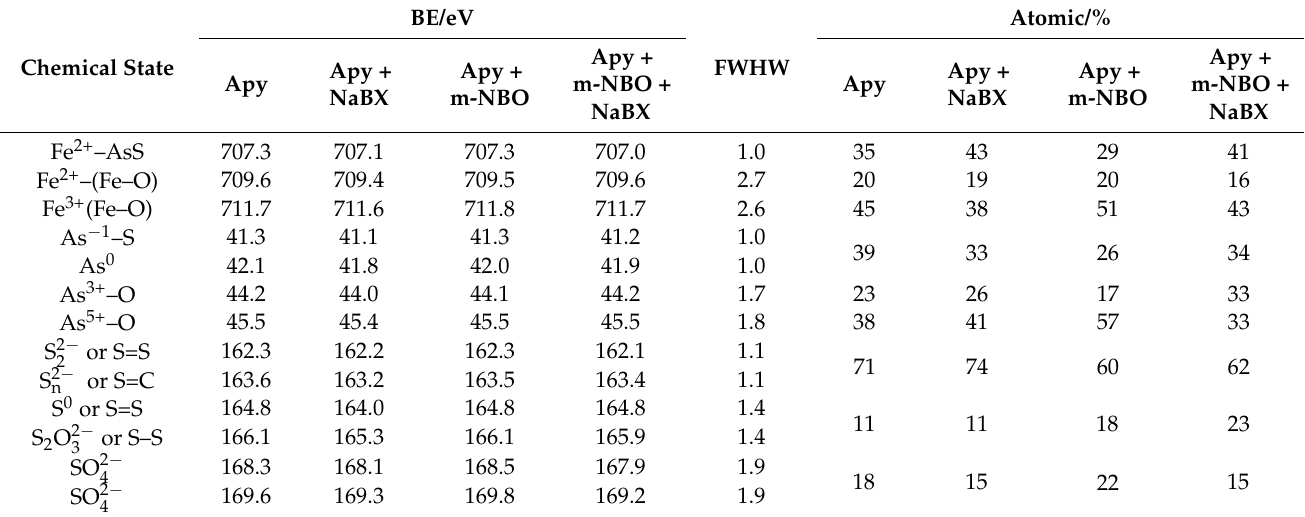
As shown in Figure 7a, 707.3 eV [36], 709.6 eV, and 711.7 eV on the surface of ar- senopyrite represent Fe 2 + –AsS, Fe 2 + ( Fe − O ) , and Fe 3 + ( Fe − O ) , respectively, and the relative atomic concentrations are 35%, 20%, and 45%, respectively, as shown in Table 4. After the treatment of arsenopyrite and NaBX, the content of low-valence oxides of ar- senopyrite increases; the content of high-valence Fe 3+ decreases; and the relative atomic concentrations are 43%, 19%, and 38%, respectively, as shown in Table 3. The adsorption of xanthate and dixanthate on the surface of arsenopyrite forms Fe ( OH ) · X and Fe ( OH )